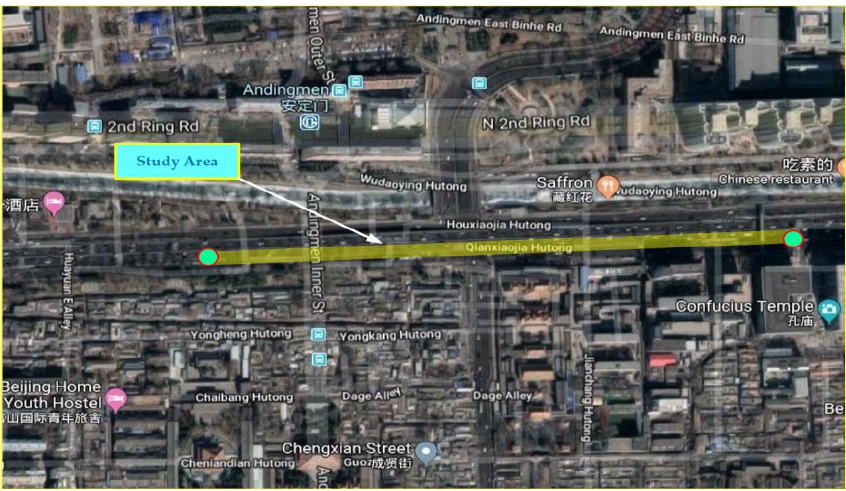
Figure 6. Basic freeway segment of the Second Ring Road (from Google Earth). Note: The Chinese words on map indicate names of surrounding infrastructure.